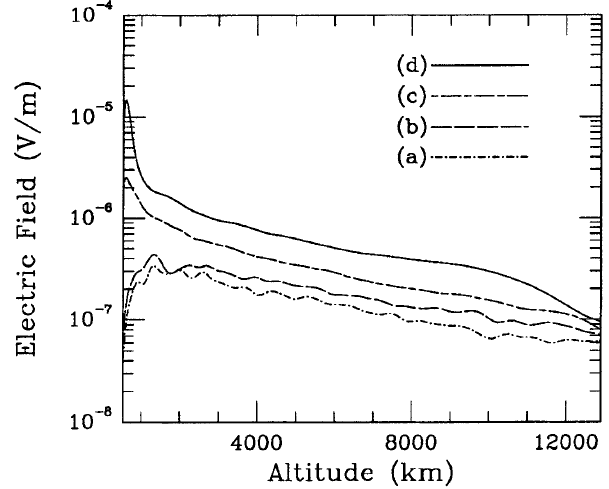
Fig. 11. Profiles of the self-consistent ambipolar electric field. Note that the local electric field increases at all altitudes with the addition of photoelectrons. The labels correspond to the cases listed in